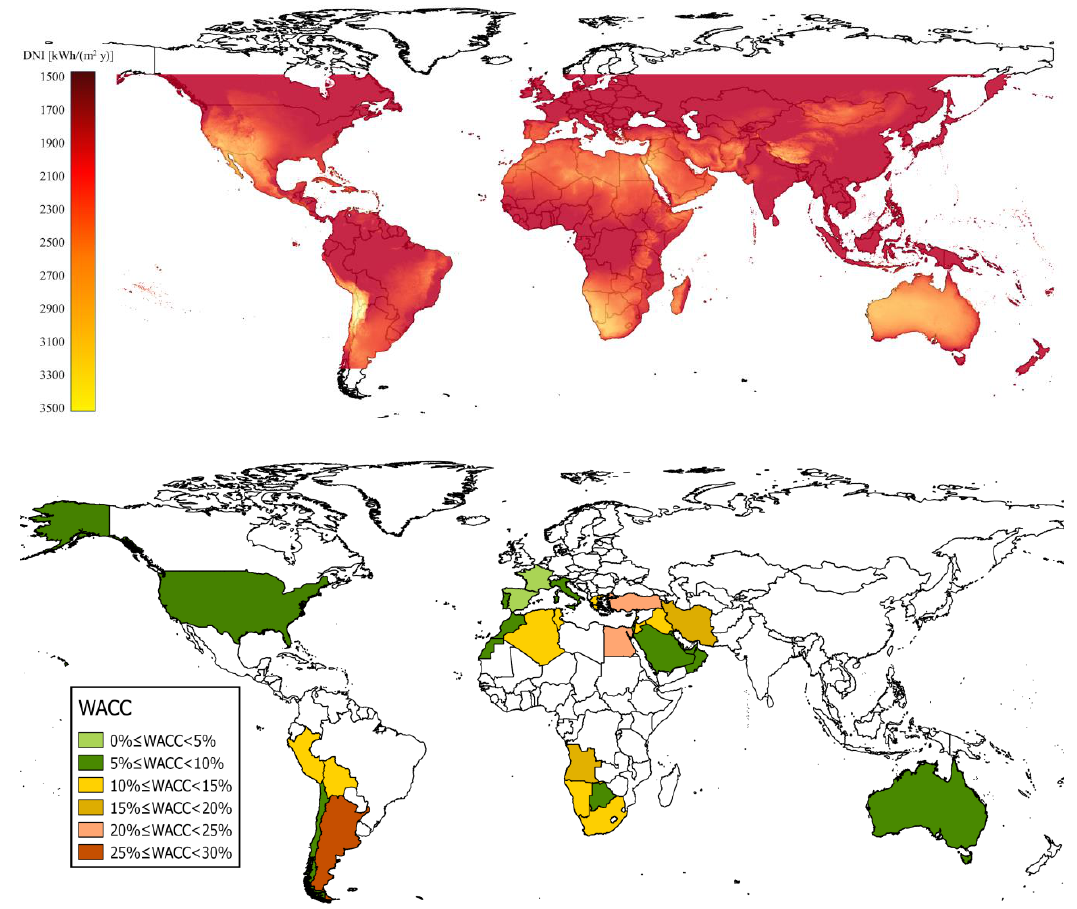
Figure 2. Direct normal irradiation (DNI, top ) and estimates of nominal weighted average costs of capital (WACC, bottom ) in the selected countries for the analysis. The most favorable locations for solar thermochemical fuel production are those with a high DNI and low WACC.